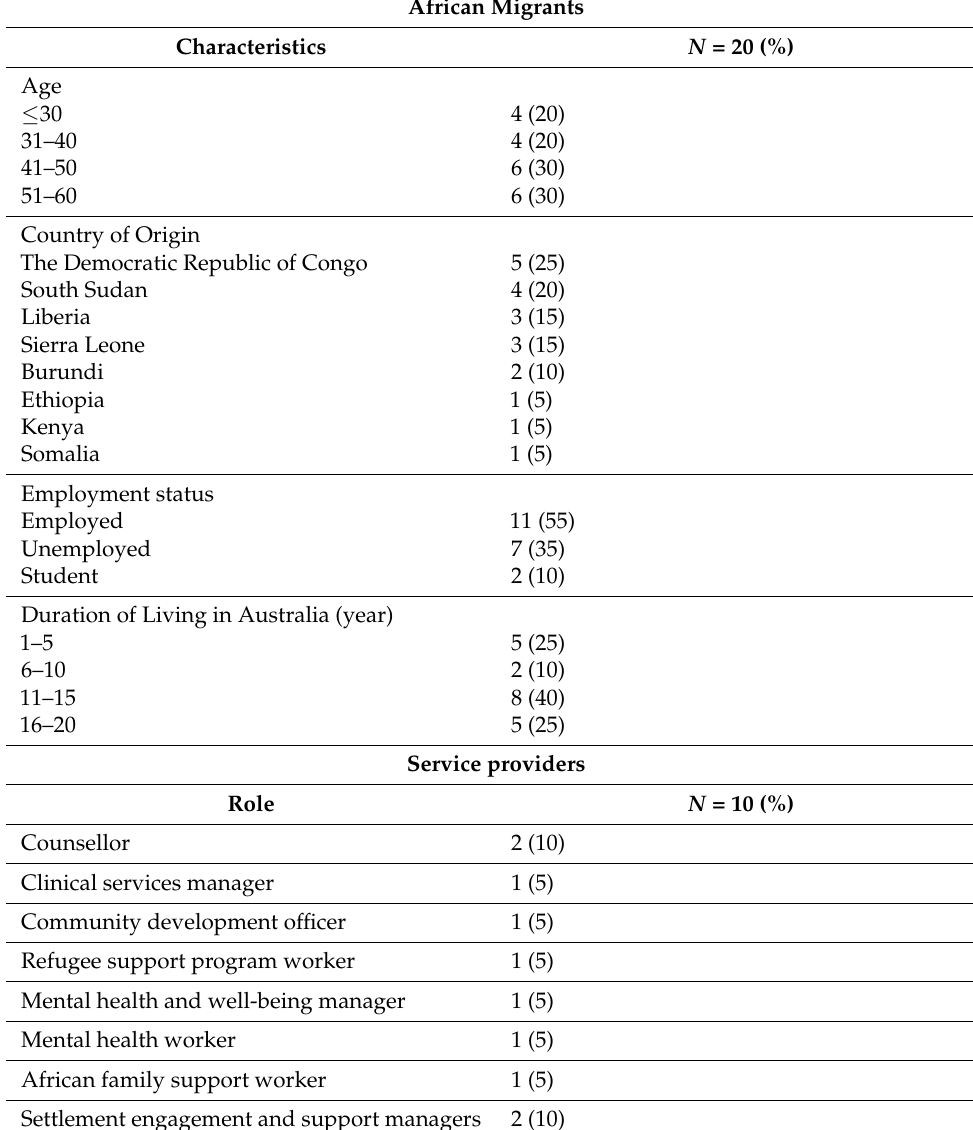
Table 1. Sociodemographic profile of the of